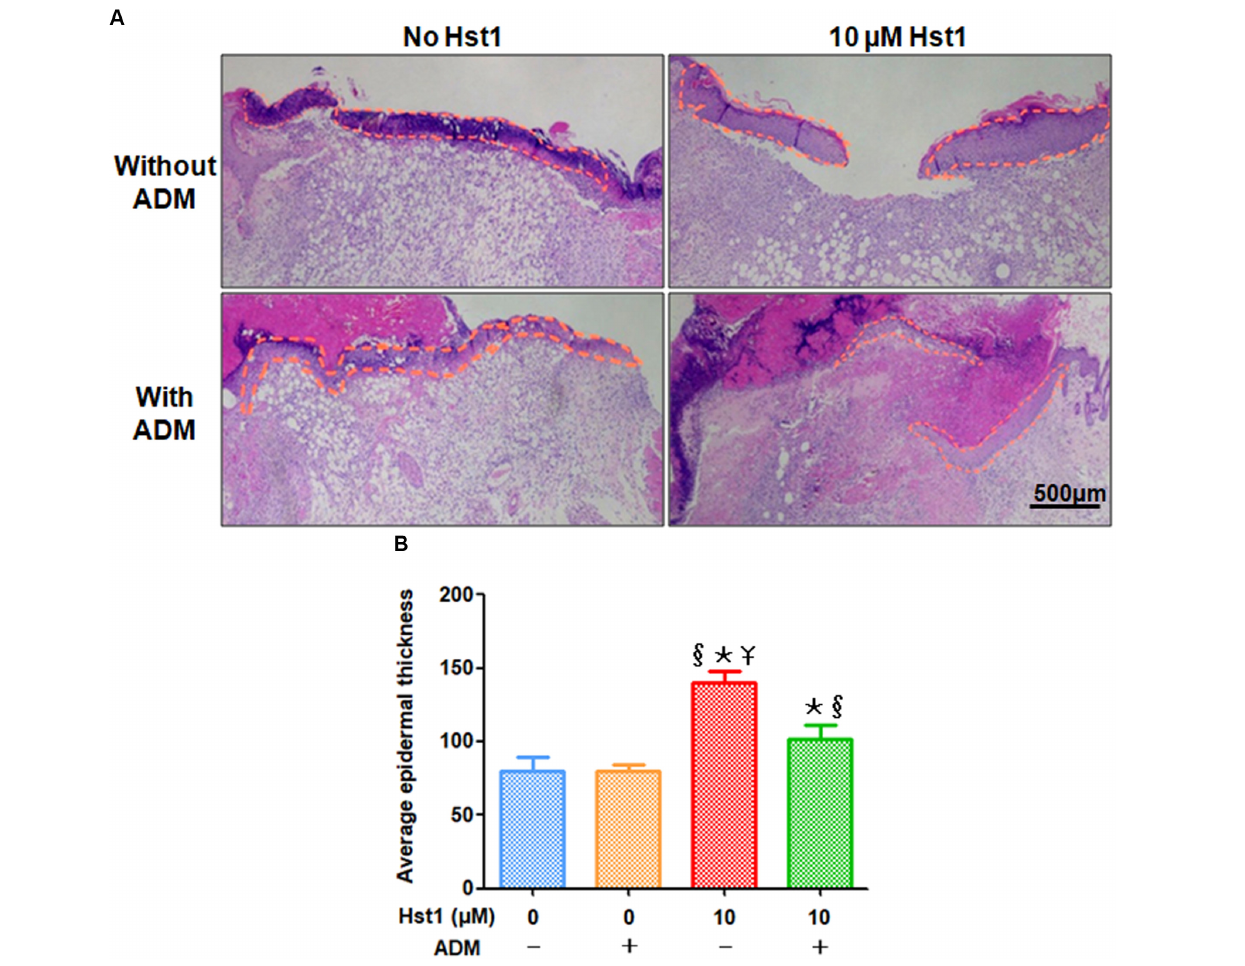
FIGURE 2 | Histological evaluation of epidermal thickness at wound sites. (A) 7 days post-surgery, the newly formed epidermal in the 10 µ M Hst1 group was thicker and cell stratification was more obvious. The yellow curve showed the epidermal regeneration area. The scale bar = 500 µ m; (B) Quantitative analysis showed that the treatment with 10 µ M Hst1 was associated with the highest thickness of newly formed epidermal layer, which was followed by ADM + 10 µ M Hst1. In contrast, ADM alone didn’t promote epidermal thickness. §: The 10 µ M Hst1 group and 10 µ M Hst1 + ADM group vs the control group; *: The 10 µ M Hst1 group and 10 µ M Hst1 + ADM group vs the ADM group; –Y: The 10 µ M Hst1 group vs the 10 µ M Hst1 + ADM group ( P <